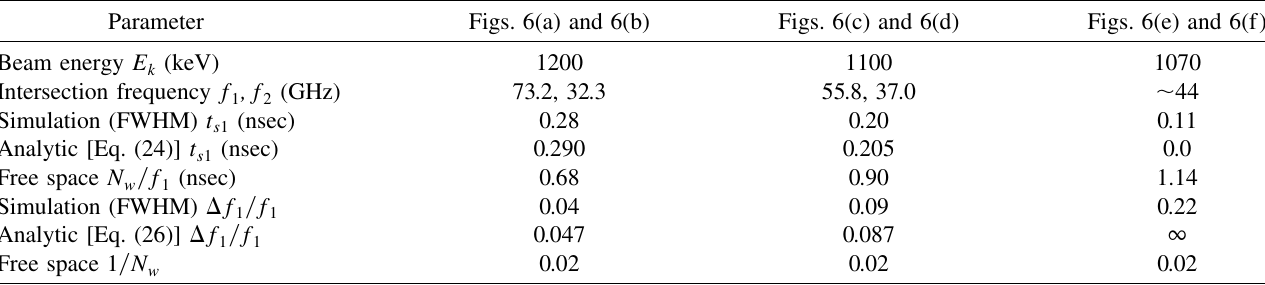
TABLE I. Pulse compression and bandwidth expansion in a dispersive waveguide.